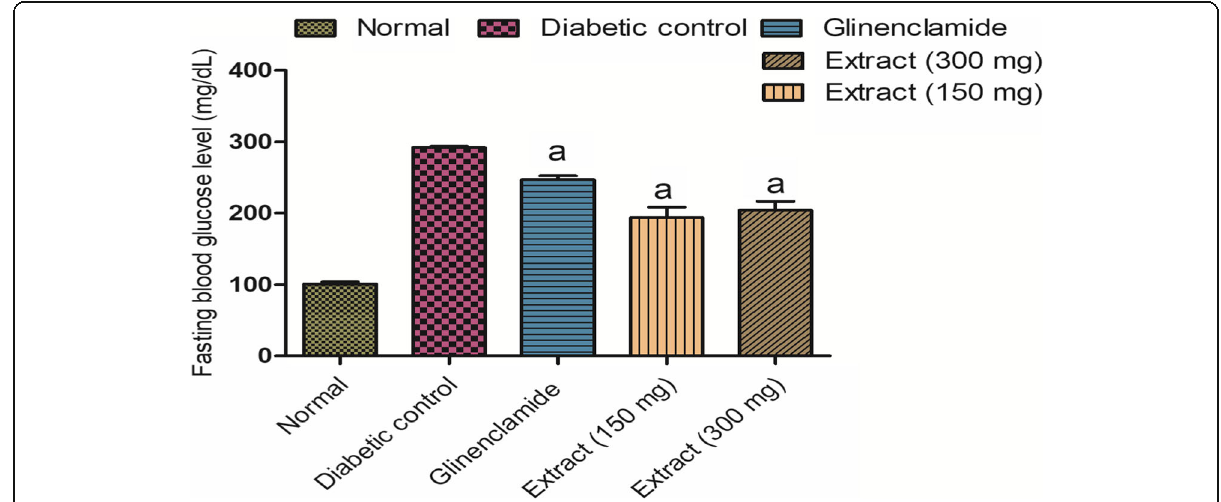
Fig. 6 Effect of Sorghum halepense (L.) Pers extract on blood glucose levels of diabetic rat; Represented the data ( n = 5) as Mean ± SD, a shows significance at P < 0.001 (Dunnett ’ s-test), the normal group was compared with untreated group and in turn, its comparison was made with extract treated group and